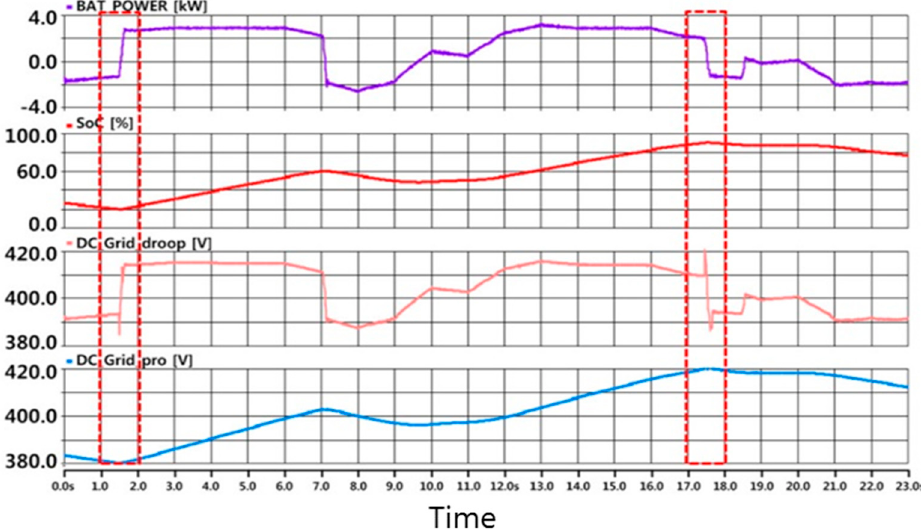
Figure 11. Simulation result comparison by existing droop control and proposed control.